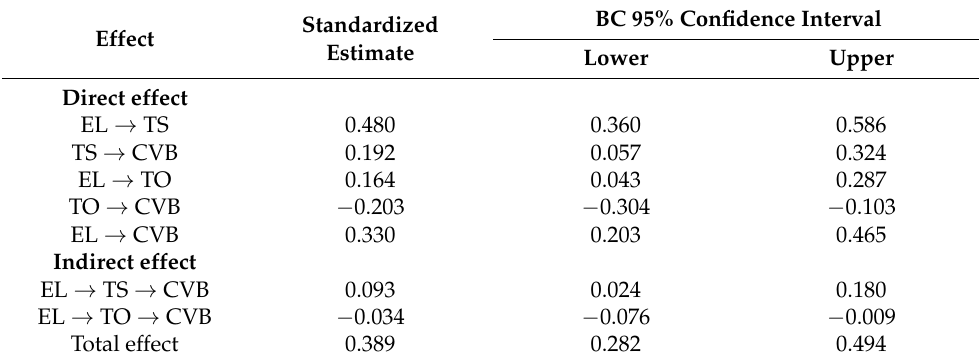
Table 5. Mediation analysis